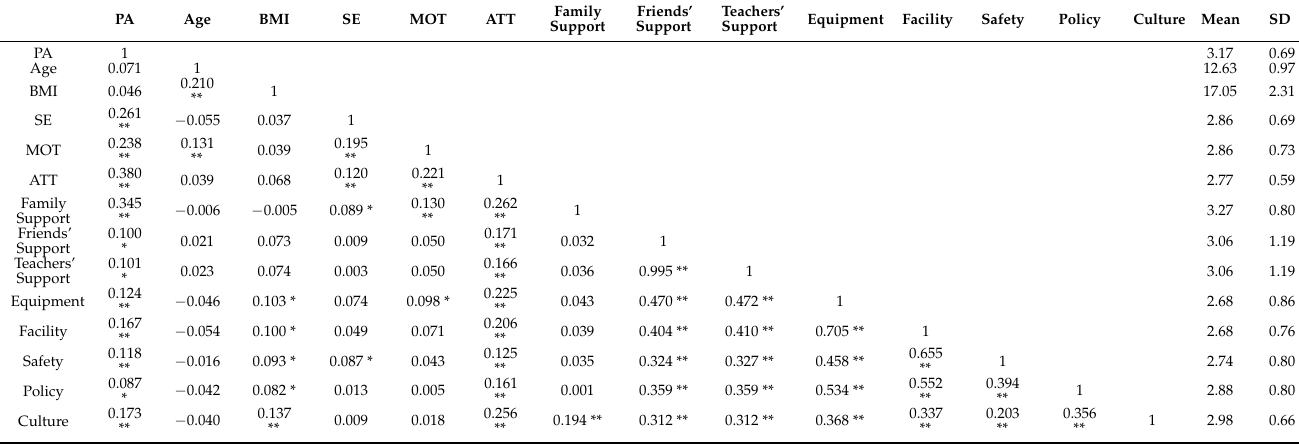
Table 3. Correlation between PA and individual, interpersonal, and organizational